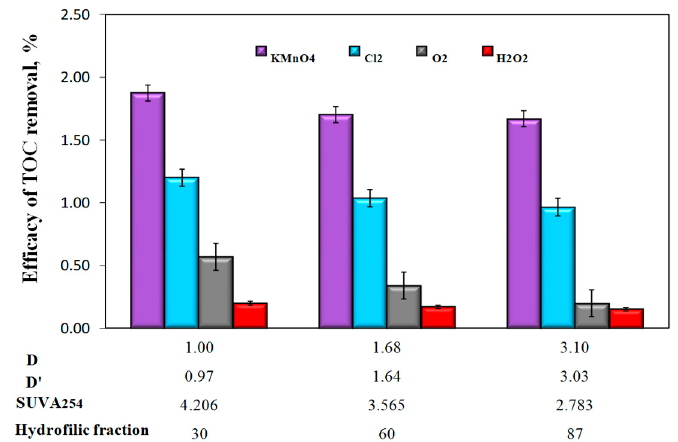
Figure 7. The influence of the type of oxidant and values of the co-occurrence coefficient of organic substances and total iron (D and D’), SUVA 254 coefficient value, and hydrophilic organic content (%) on the efficiency of TOC removal from water in the sedimentation process.